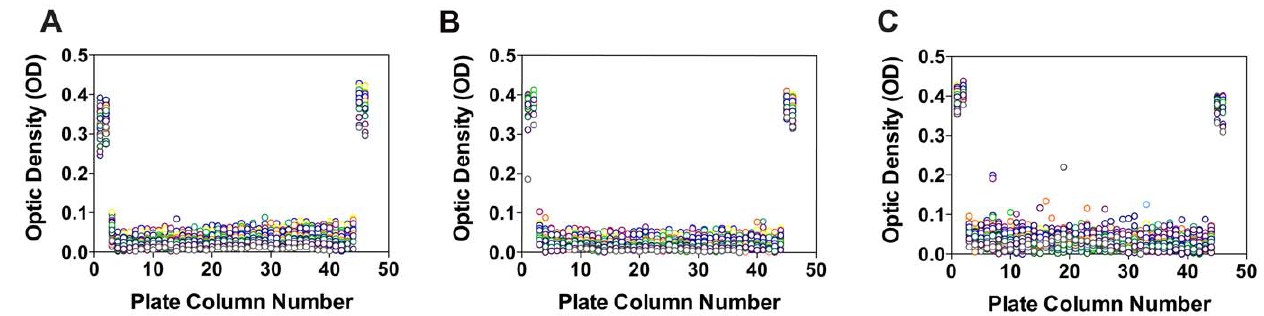
Figure 6. Scatter plot from the quantitative cell-based HTS assay for ASA using the LOPAC library. In each panel, columns 2, 3, 46 and 47 depict OD values from wells with control cells (ASA-WT), which were not exposed to small molecules. OD values from MLD patient fibroblasts (ASA-I179S) treated only with DMSO were located in columns 4 and 45. SV40t MLD patient fibroblasts were seeded in columns 5 to 44. The 1,536-well plates treated with DMSO (0.57%) ( A ), lowest (7 6 10 2 3 ; B ) and highest (114.2 microM; C ) concentrations of LOPAC are shown. Small molecules, demonstrating increased ODs in the plot C, were studied further in the curve analysis. (Table S1 and Fig.7A–D). Two candidate compounds were